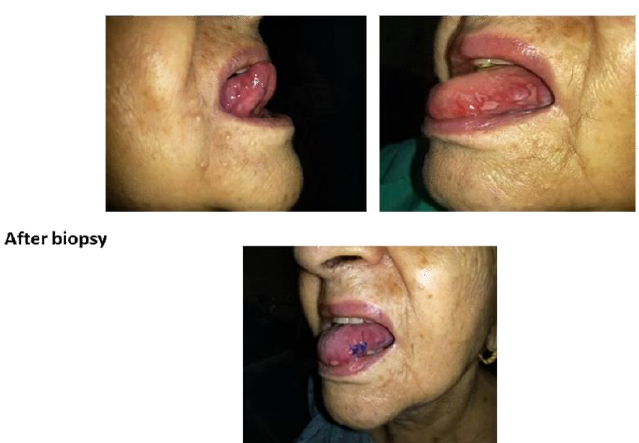
Figure 12. Pictures show lesions in both side of the tongue of the patient before treatment and suture points after a biopsy. The patient is 84 years old, and she had not received chemotherapy/radiotherapy treatment.